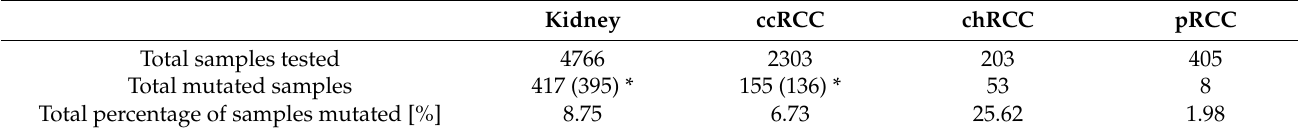
Table 1. Distribution of mutations in Tp53 /p53 across kidney and sub-histological types of RCC based on data from the COSMIC database (https://cancer.sanger.ac.uk/cosmic/gene/, accessed on 1 May